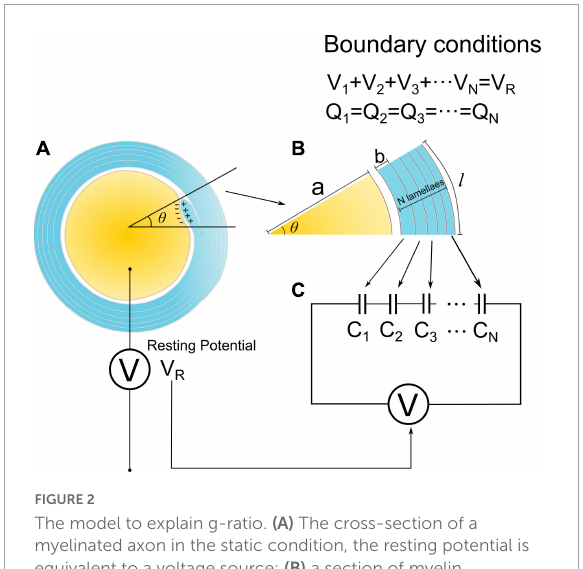
FIGURE2 The model to explain g-ratio. (A) The cross-section of a myelinated axon in the static condition, the resting potential is equivalent to a voltage source; (B) a section of myelin cross-section with a radial angle of θ ; (C) the equivalent circuit modeling the myelin